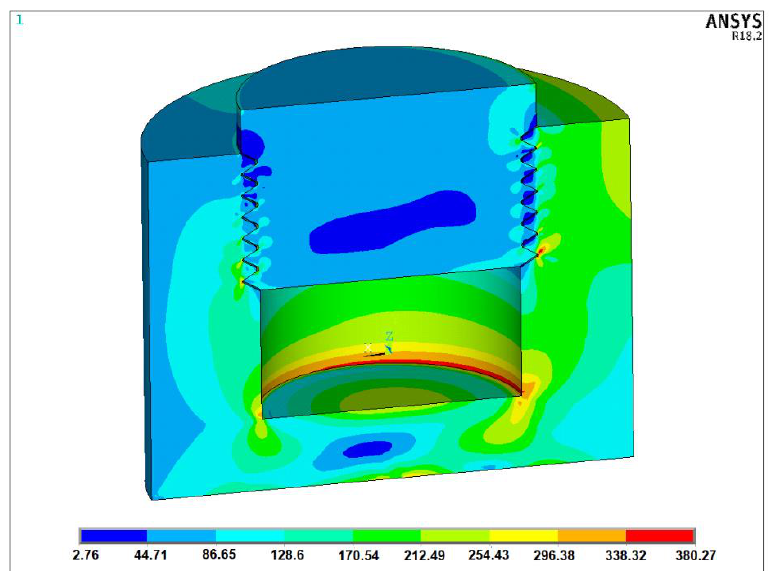
Figure 8. The resulting stresses obtained by measured values of tensile and bending loading (measured on the outer surface of the guide bar according to Figure 6).